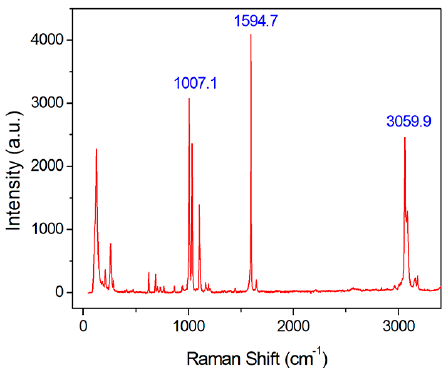
Figure 6. Raman scattering spectrum of the TPPB (2H 2 O) single-crystal excited by a 473 nm laser.